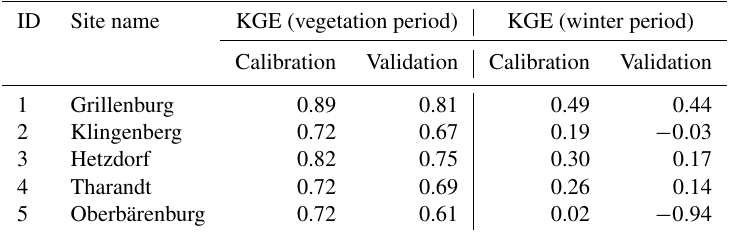
Table 2. Daily Kling–Gupta efficiency for BROOK90 calibration and validation.